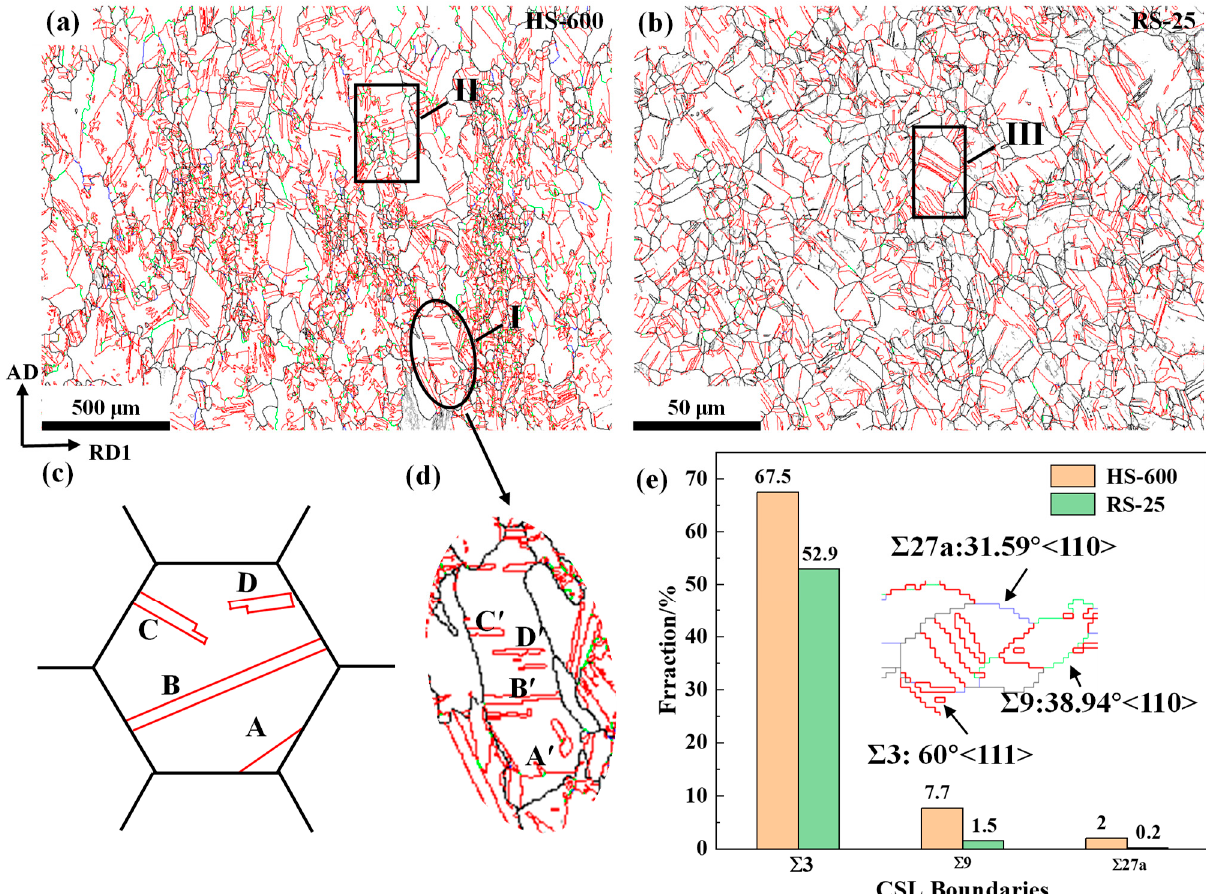
Figure 7. GBs map for ( a ) HS-600 and ( b ) RS-25, respectively; ( c ) schematic diagram of annealing twin prominent morphologies; ( d ) an enlarged image of the encircled area I in Figure 7a; and ( e ) the statistics data of twins.